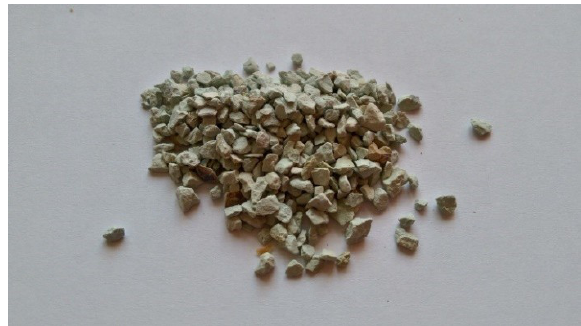
Figure 1. Zeolite-clinoptilolite, fraction 2.5 to 5 mm [23].